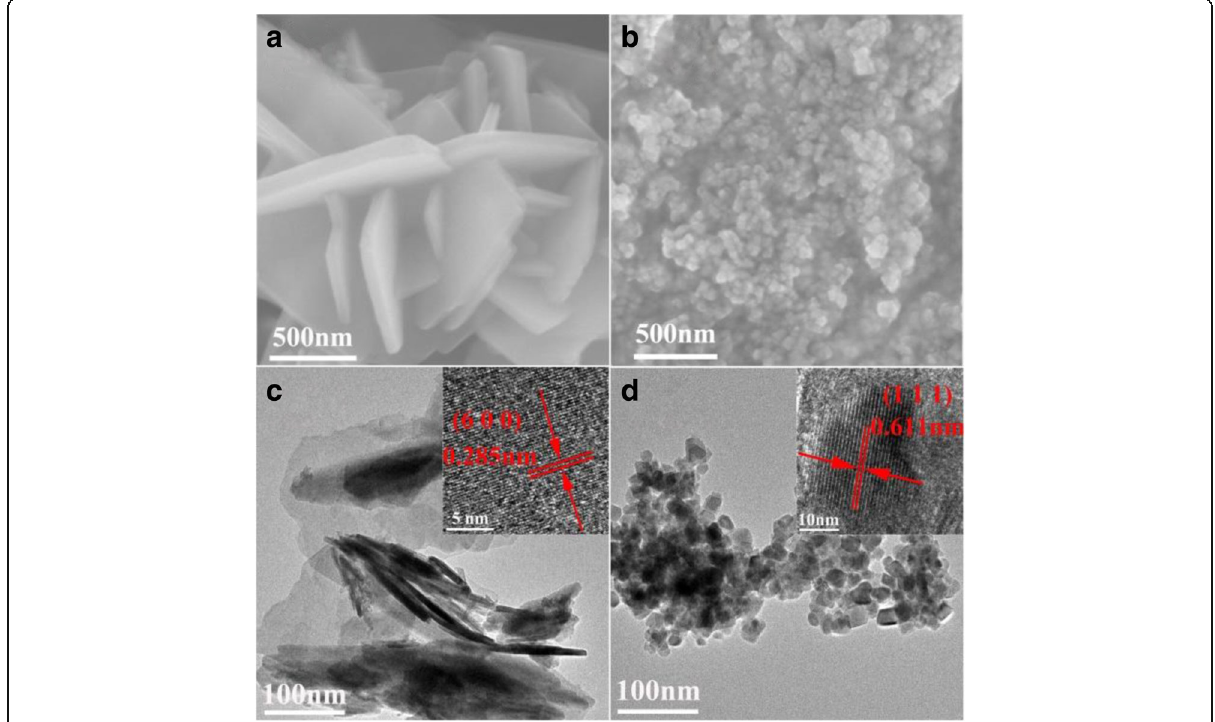
Fig. 2 Typical SEM and TEM images of SnNb 2 O 6 ( a , c ) and Sn 2 Nb 2 O 7 ( b , d ).The insets are the HRTEM images of the